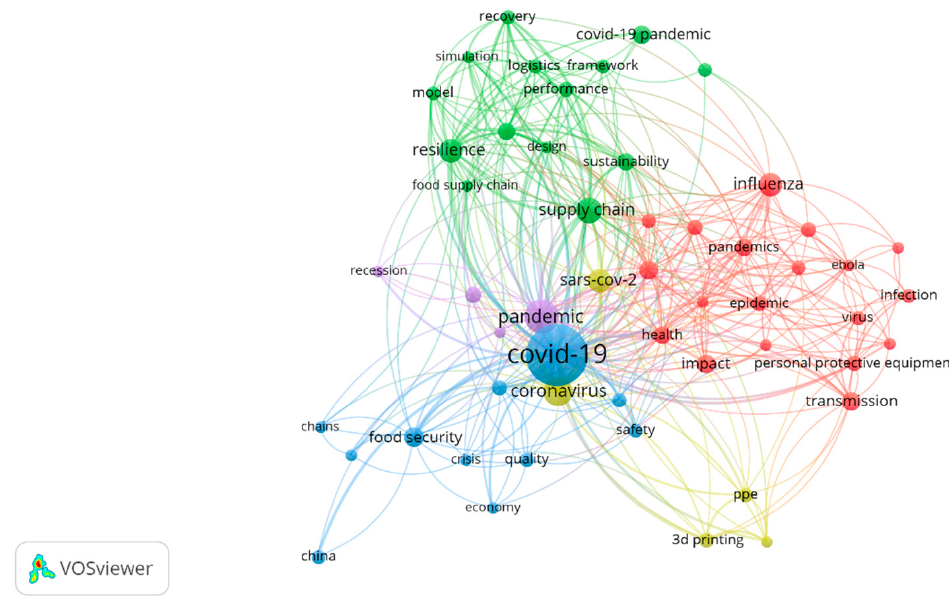
Figure 7. Article Connectivity and Overlapping Analysis.